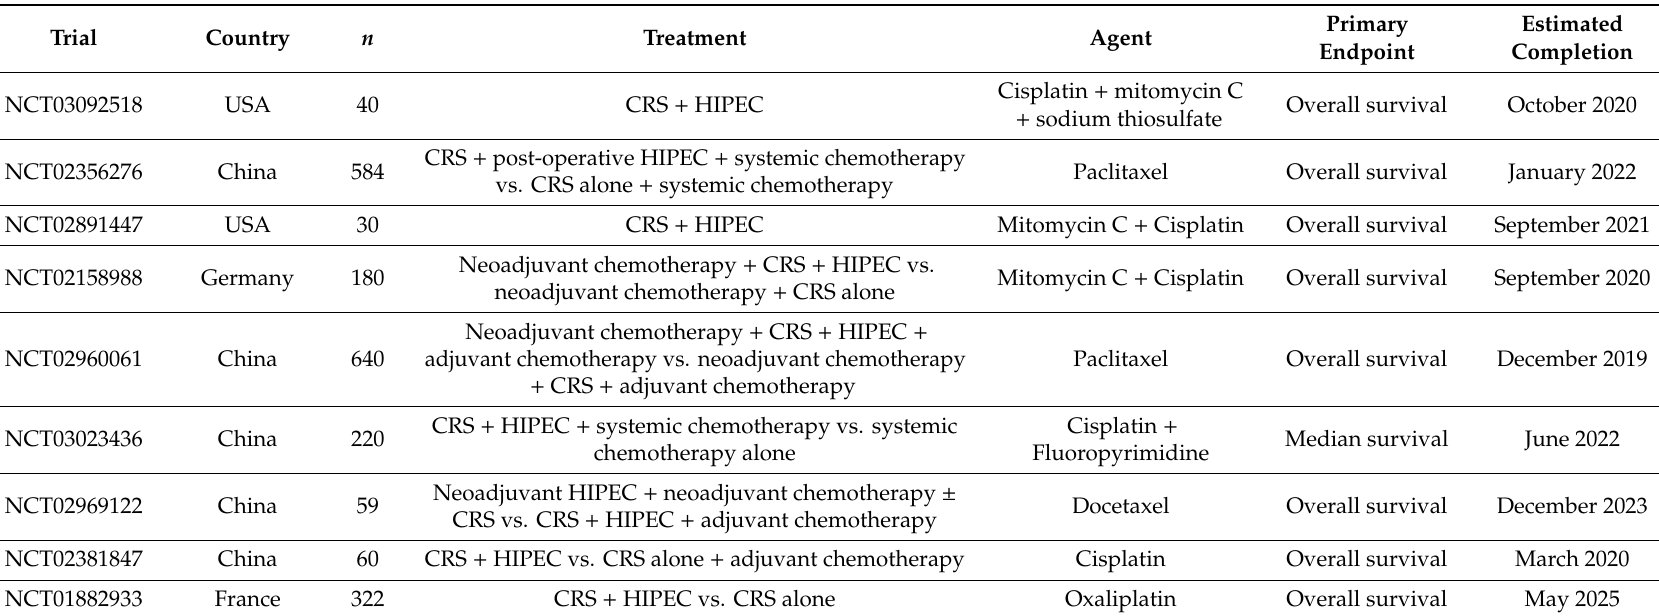
Table 3. Active gastric cancer CRS and HIPEC clinical